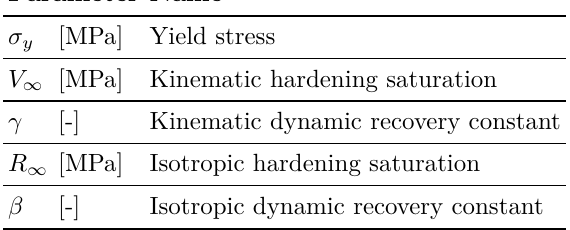
Table 1. Model parameters to be identified.